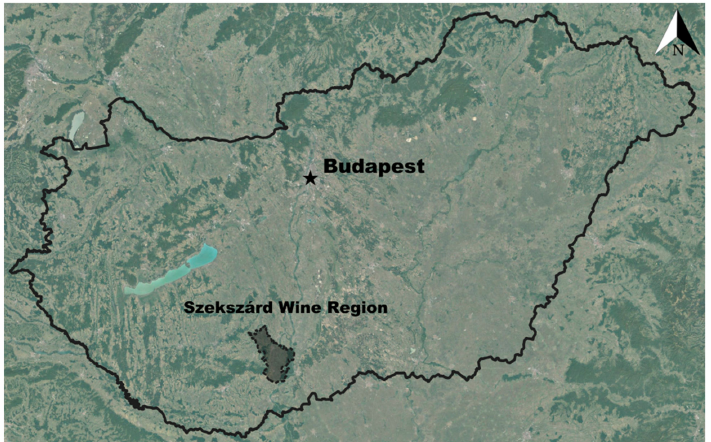
Figure 1. Location of the study